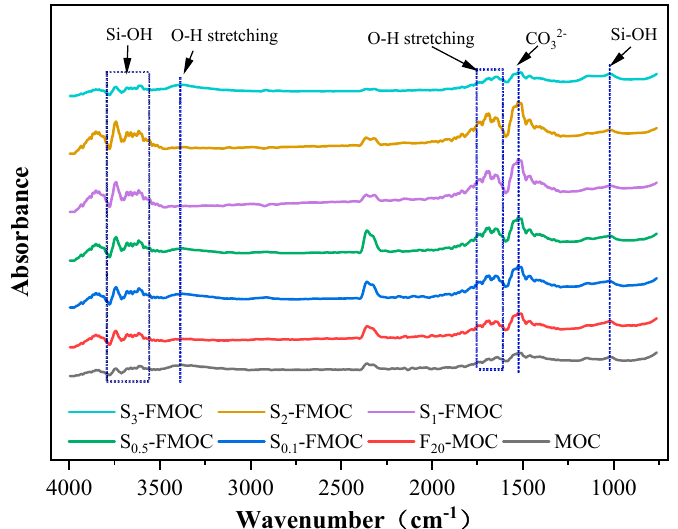
Figure 13. Infrared spectra of hardened and multi ‐ doped MOC.